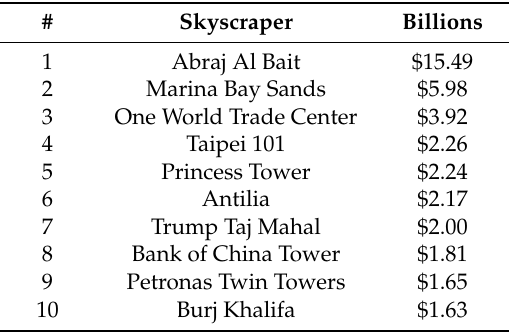
Table 1. Skyscrapers are costly buildings [59].